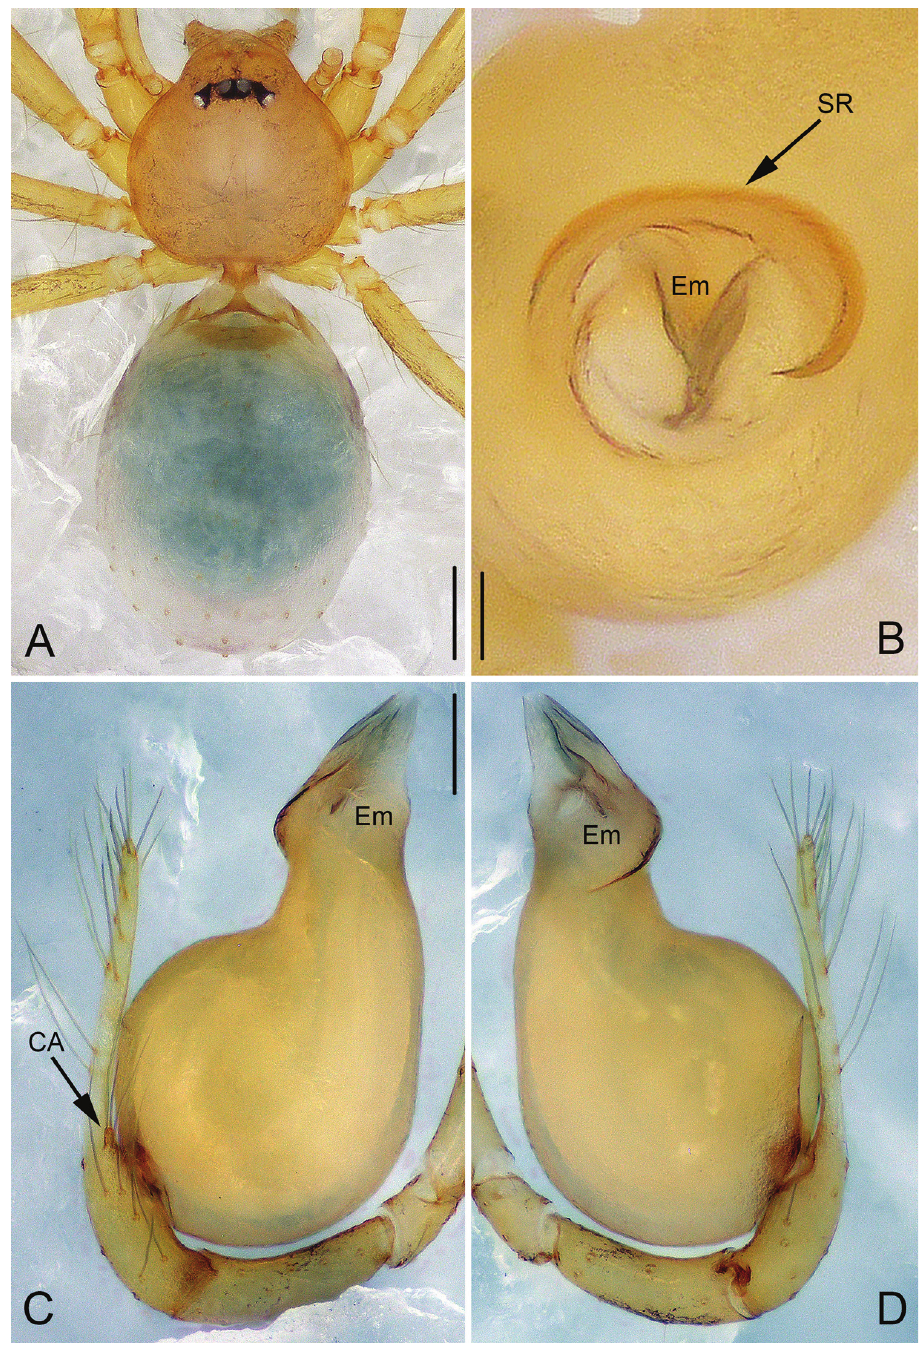
Figure 1. Pinelema cunfengensis sp. n., male holotype. A Habitus, dorsal view B Tip of embolus, apical view C Palp, prolateral view D Palp, retrolateral view. Scale bars: 0.2 mm ( A ), 0.05 mm ( B ), 0.1 mm ( C–D